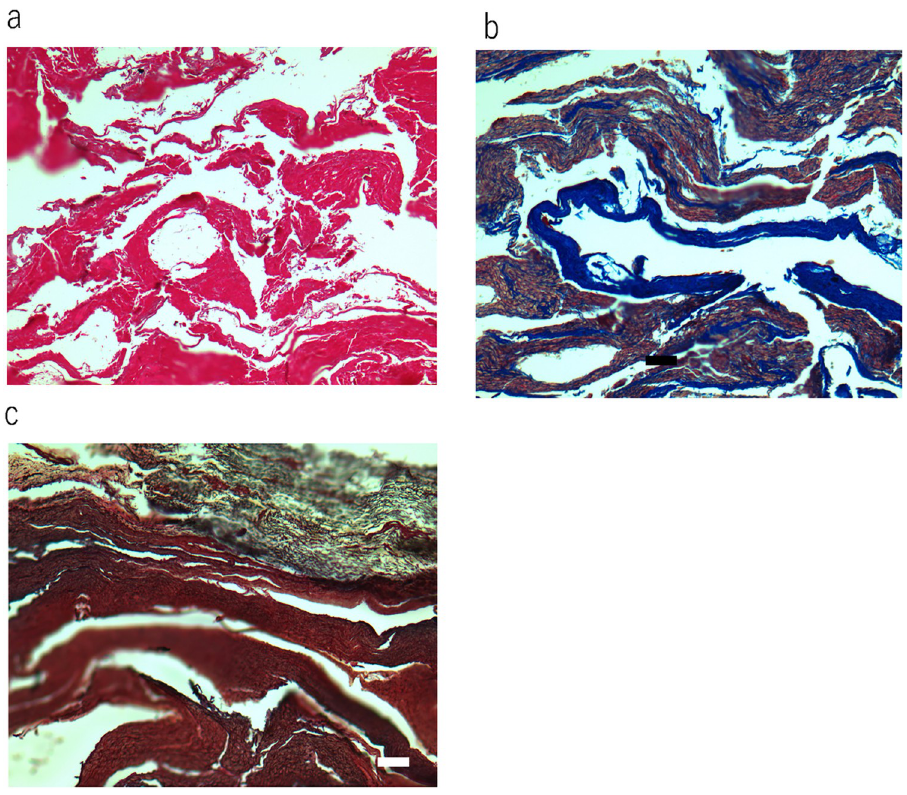
Fig 2. Histochemical observation of soft tissue of mammoths. (a) Haematoxylin and eosin staining of liver section from Dima. Scale bar is 100 μ m. (b) Azan staining of liver section from Dima. Scale bar is 100 μ m. (c) Ishii–Ishii’s silver impregnation of liver section from Dima. Scale bar is 100 μ m.